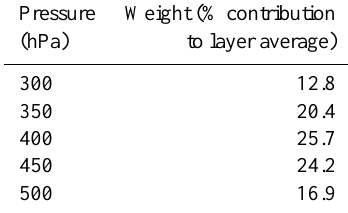
Table 1. Vertical weighting function applied to ozonesondes for comparison to MUTOP, based on the GOES specific humidity con- tribution weighting function (layer average is simplistically defined as the sum of the ozone volume mixing ratio at each pressure level multiplied by the contribution weight; there is no ozonesonde con- tribution from below 500 or above